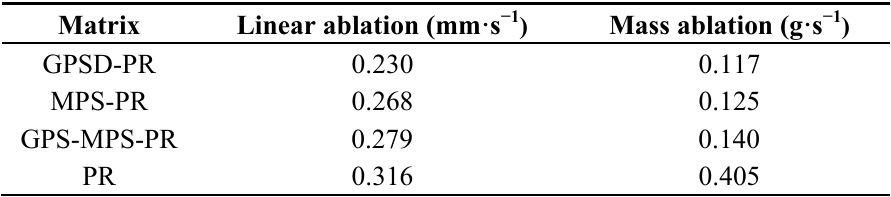
Table 1. Results of the ablation test for different